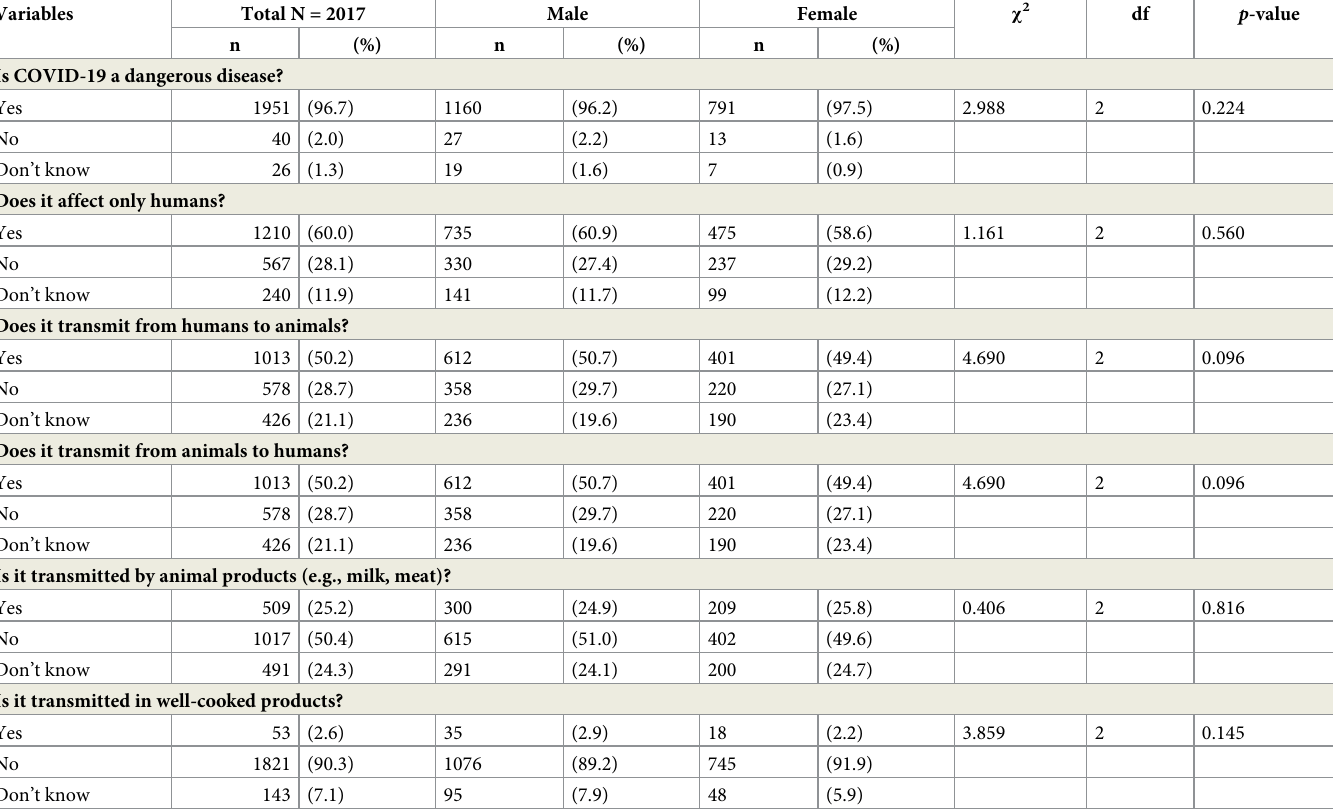
Table 3. Knowledge and gender difference of participants (N =